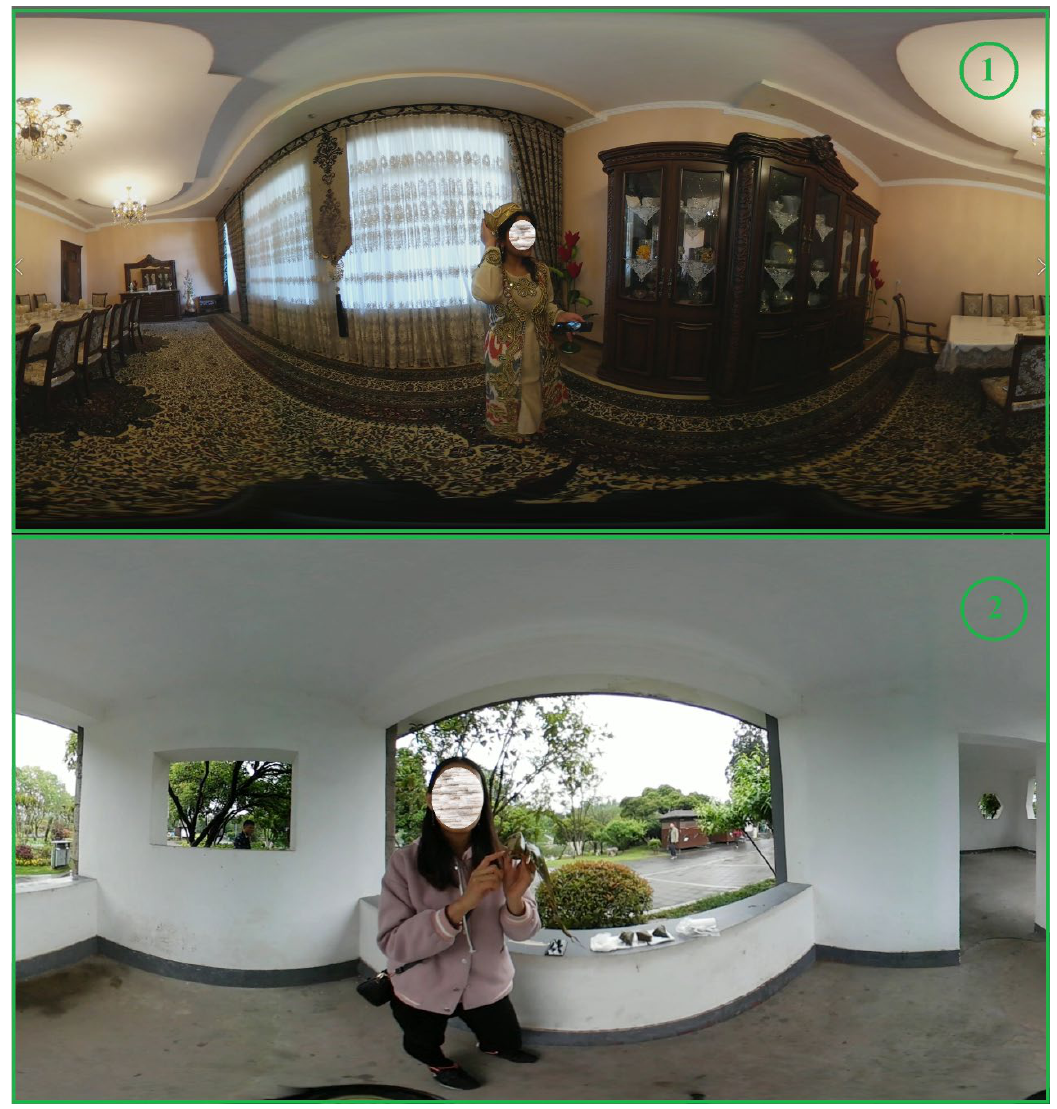
Figure 1. Screenshots from a 360-degree